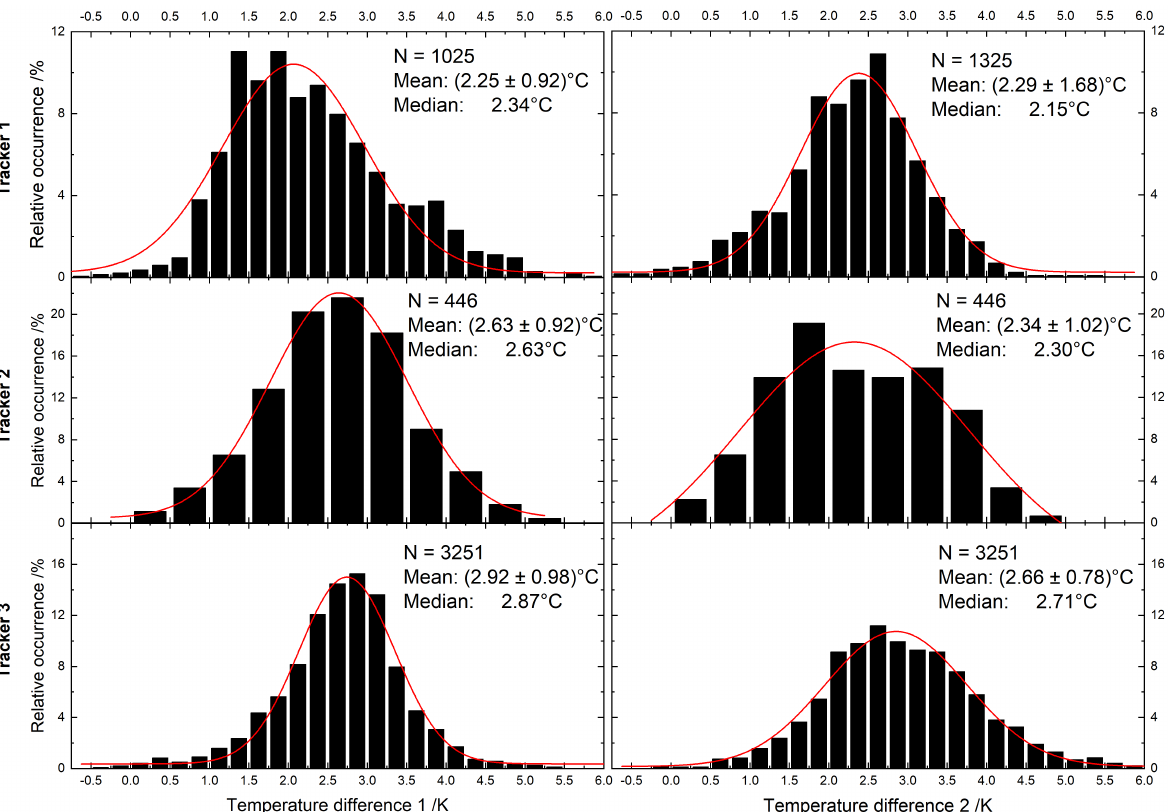
Figure 11. The distribution of temperature difference at the TEG in each of the trackers harvesting housings. Given: the total number of measurements for each tracker (N), mean and median for each housing, and a calculated normal